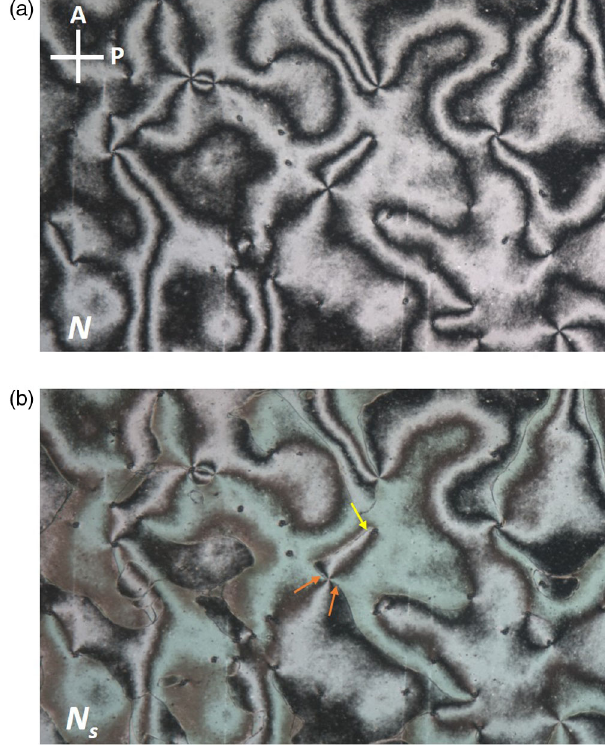
FIG. 4. Polarization microscopy images in (a) N ( 135 °C) and (b) N ( 125 °C) phases in a homeotropic cell (thickness 18 μ m). S The appearance of two additional defect lines around (cid:2) 1 defects and one around (cid:2) 1 = 2 defects in the N phase indicates that the S symmetry of this phase is lower than that of the N phase. The polarizer and analyzer are oriented as shown in (a). The width of the images is 545 μ m. The yellow and orange arrows point at additional lines around one (cid:2) ½ and one (cid:2) 1 defect, respectively.